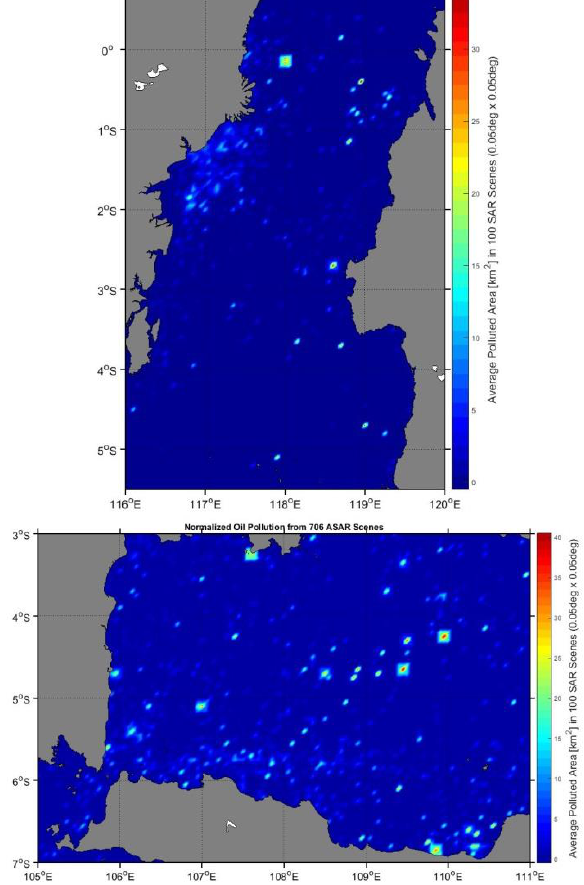
Figure 7. Normalized mean polluted area per 0.05° × 0.05° grid cell and per 100 SAR images, as detected in approx.